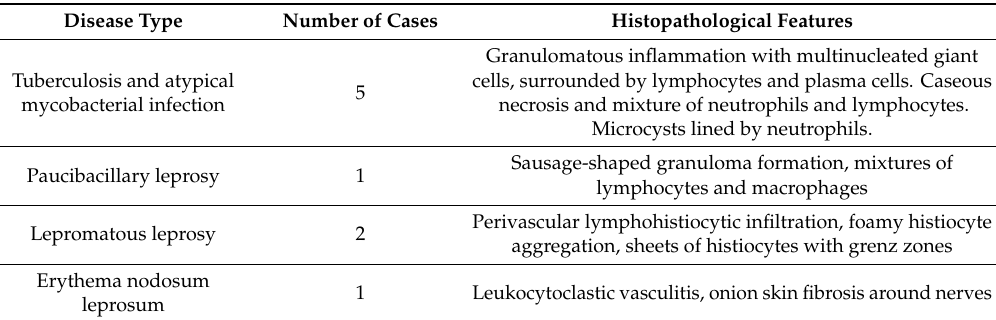
Table 1. Histopathological features of the nine selected skin incisional biopsy tissue